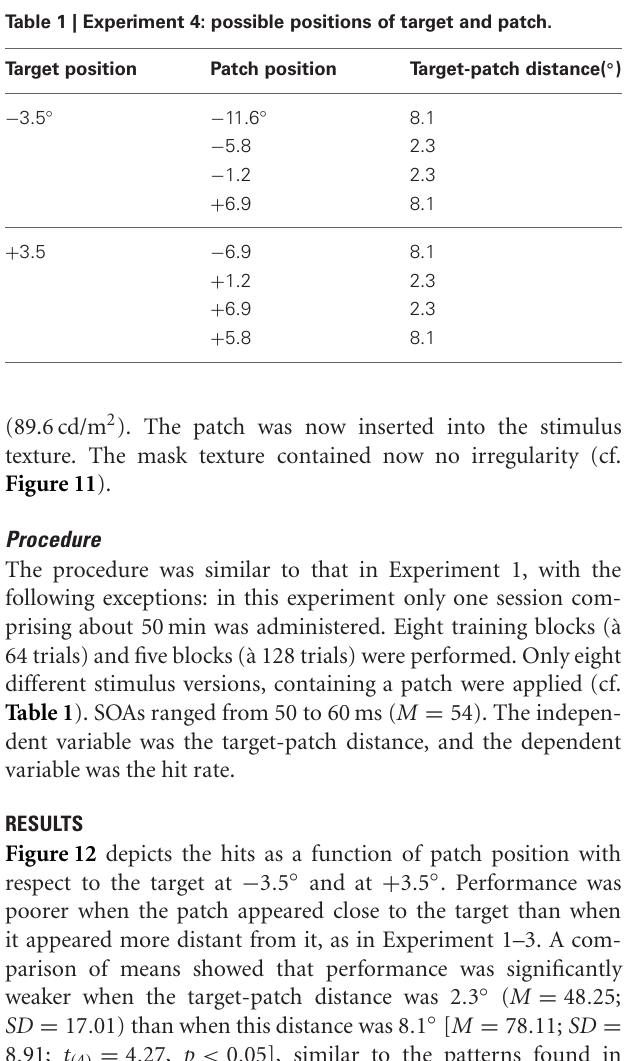
persisted when target and patch appeared simultaneously.